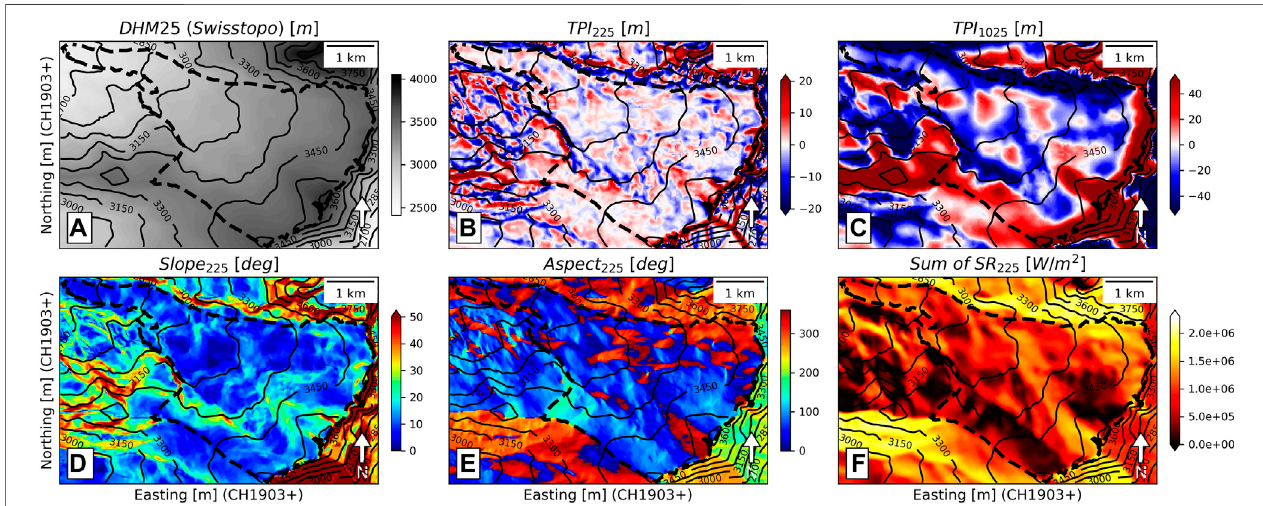
FIGURE 3 | Example of the topographical parameters derived from DHM25 (A) for Findel glacier (glacier outline shown with the dashed line) including elevation contours (solid lines). The TPIs computed with a 225 × 225 m 2 and 1025 × 1025 m 2 moving window, respectively, are shown in (B , C) . The slope and aspect computed witha225 × 225m 2 movingwindow areshown in (D , E)(F) presentsthesum ofthemodeledsolarradiationcomputedwitha225 × 225m 2 movingwindow, forthe2019/ 20 winter season.